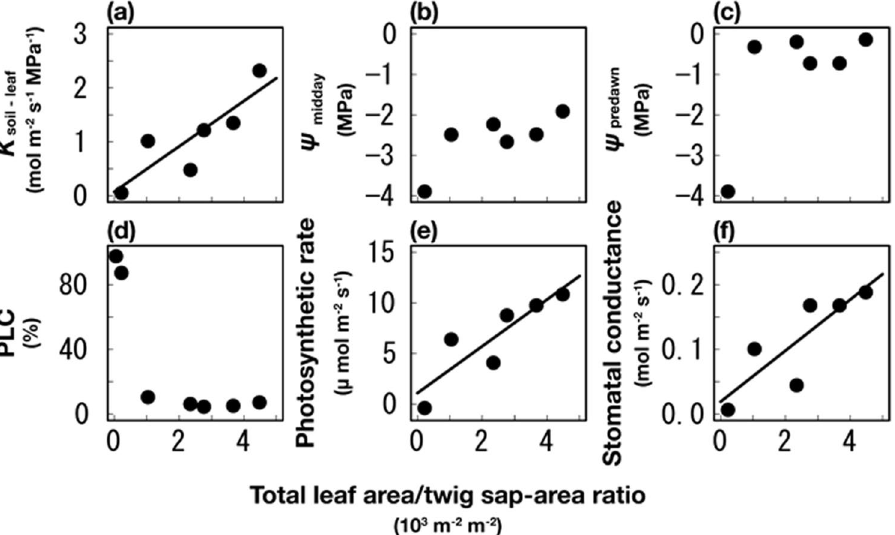
Figure 1. Mean hydraulic and leaf gas exchange values in individual trees with different leaf area/twig sap area ratios (degrees of tree health). ( a ) Soil-to-leaf hydraulic conductance. These values were calculated from the transpiration rates and the difference between the predawn and midday leaf water potential. ( b ) Leaf water potential at midday. ( c ) Leaf water potential at predawn. ( d ) Percentage loss of conductivity (PLC) in the branchlets (6 mm in diameter). ( e ) Near-light saturated net photosynthetic rate per unit area. ( f ) Maximum water-vapor stomatal conductance. Because the dead tree have no leaves, we could not measure leaf-rerated physiological parameters ( a , b , c , e and f ). Ordinary least-squares linear regression lines were drawn for statistically significant results ( α = 0.05), and the dotted line indicates the decreasing trend of leaf water potential with declining tree health ( R 2 = 0.60, p = 0.07). The measurement of PLC was conduced in 7 trees, including the dead tree; PLC in the dead tree was